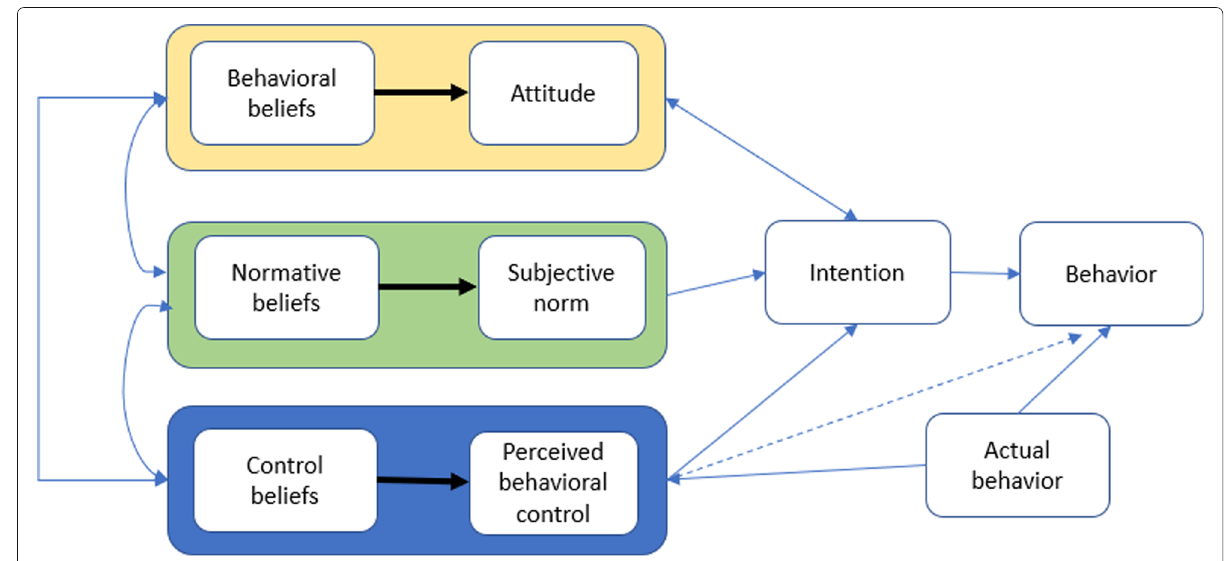
Fig. 4 Theory of Planned Behavior diagram, from Icek (2019)